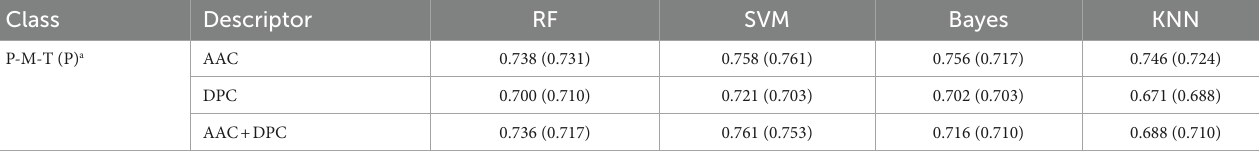
TABLE 2 Prediction accuracies of ternary classification model for psychrophilic, mesophilic, and thermophilic proteins.